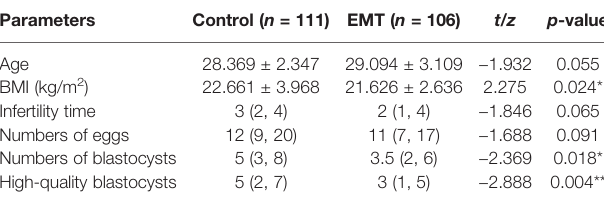
TABLE 1 | General characteristics of control subjects and patients with EMT.